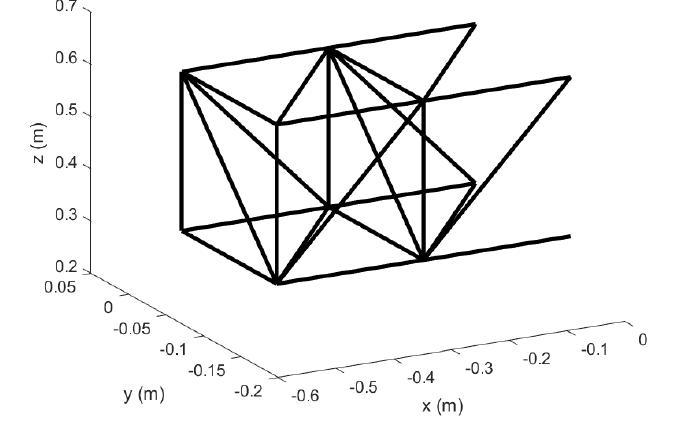
Figure 39. Un–morphed wing in Topology 2 with hinged ends; original